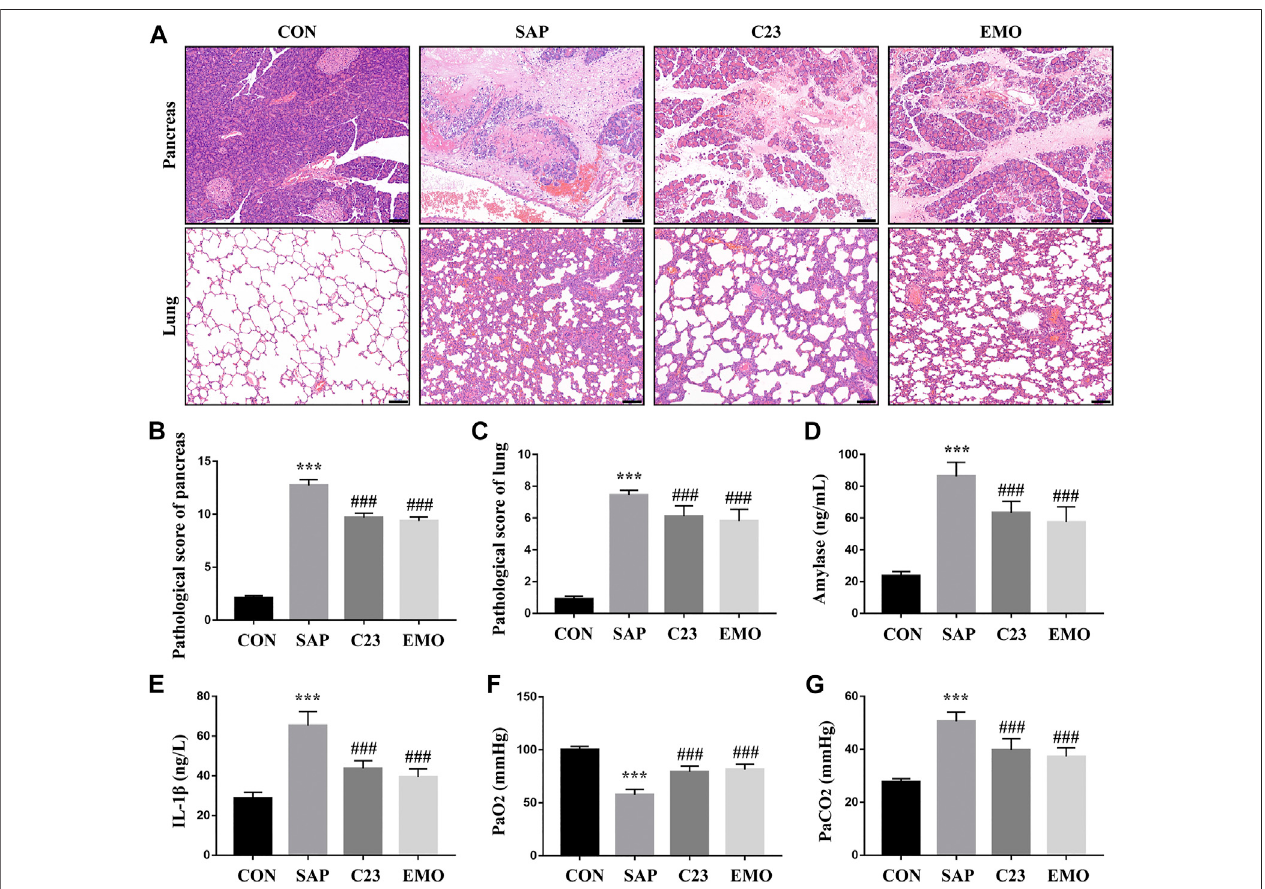
FIGURE 1 | Treatment with emodin or C23 effectively alleviates the severity of SAP-ALI in rats. (A) Hematoxylin and Eosin (HE) staining analysis of the pathological changes in the pancreatic and lung tissues (100 × magni fi cation). (B, C) Quantitative analysis of pathological scores. (D) ELISA analysis of serum amylase levels. (E) ELISA analysis of serum IL-1 β levels. (F, G) The analysis of blood arteria gas. The data are representative images or expressed as mean ± SD of each group of rats ( n (cid:1) 10 per group) from at least three separate experiments; *** p < 0.001 vs. the CON. ### p < 0.01 vs. the SAP. Scale bar (cid:1) 100 μ m.